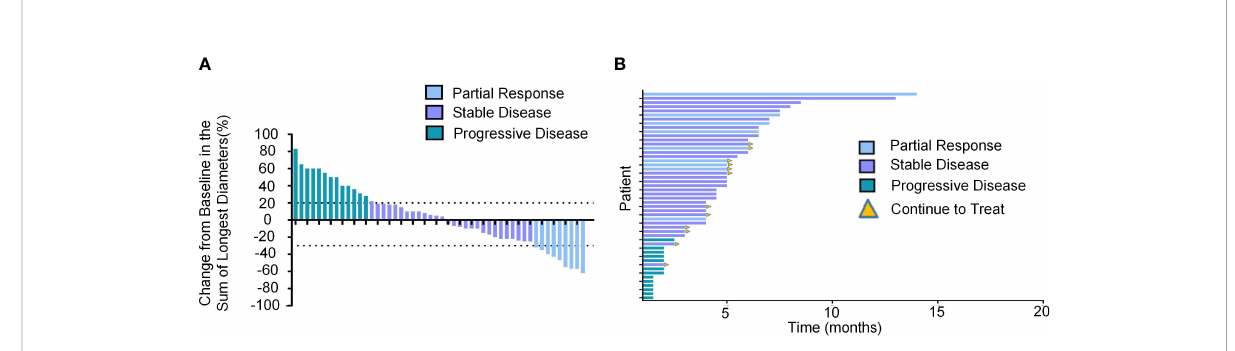
FIGURE 2 Tumor response of unresectable HCC patients treated with lenvatinib as the second-line treatment. (A) Best percentage change from baseline in the sum of the longest diameters of target lesions per response assessment in unresectable HCC patients (n=50). (B) DoR in unresectable HCC patients treated with lenvatinib as the second-line